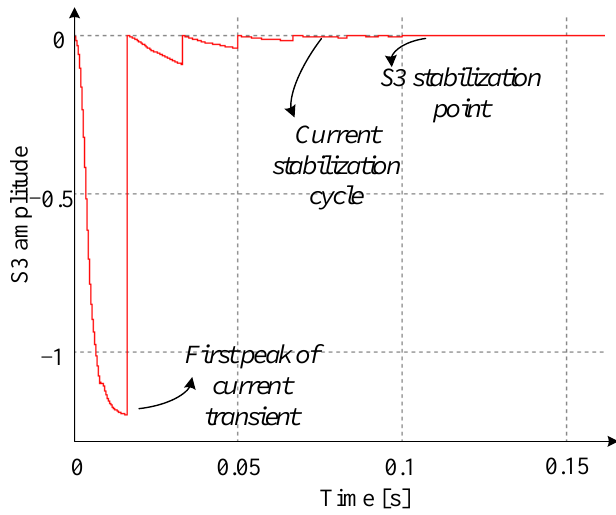
Figure 13. Integral of current error in start-up.